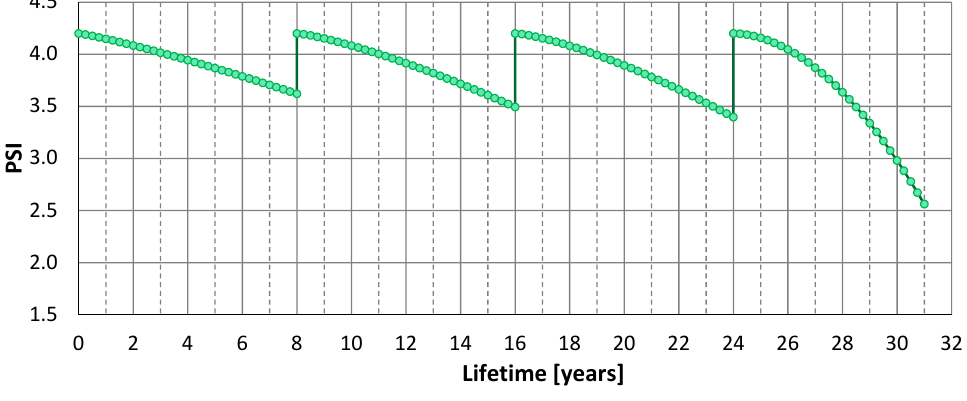
Table 5. Maintenance and planned operations of standard, gap-graded, and dense-graded scenarios.